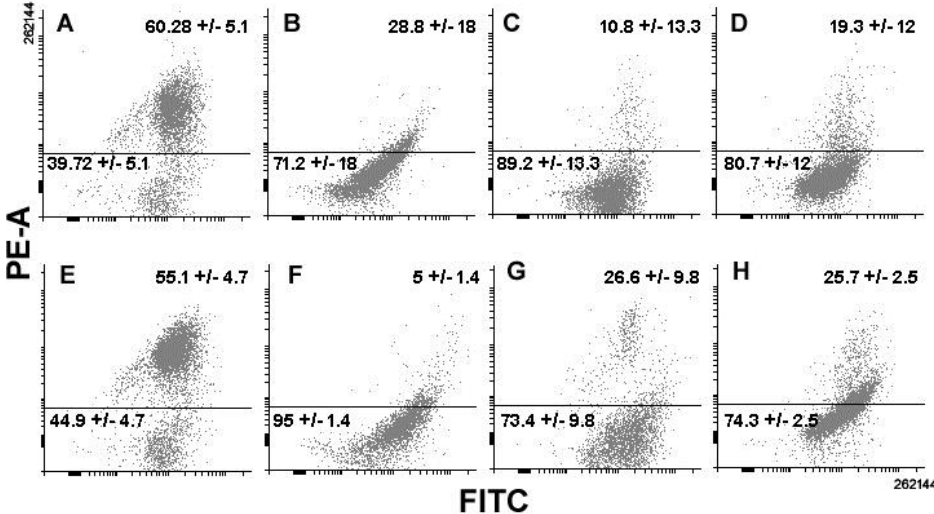
Figure 5. Representative flow cytometric analyses of the transmembrane mitochondrial potential (MMP) in control ( A , E ), total extract- ( C , G ), and 10K fraction-treated ( D , H ) MDA-MB231 cells for 24 ( A – D ) and 48 h ( E – H ). Dot plots ( B ) and ( F ) show the parallel positive controls of valinomycin-treated cells. The values indicated in the bottom quadrants in each frame quantitate the percentage of low red-emitting cells that underwent dissipation of MMP. The results are expressed as mean ± s.e.m. of triplicate